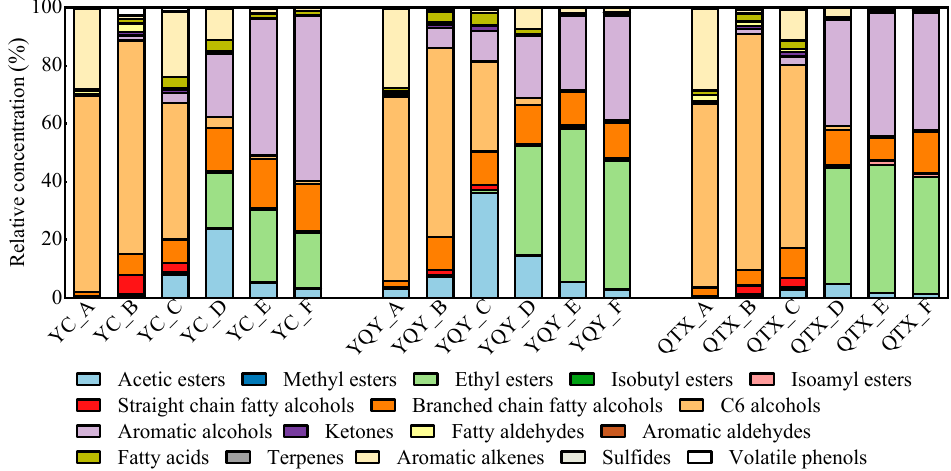
Figure 6. Relative concentrations of VOCs in different fermentation stages of different sub-regions.